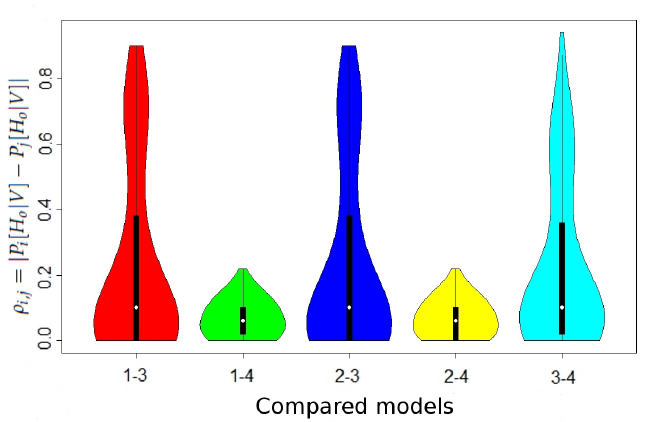
Figure 1. Distribution of ρ i , j at locus D5S818 in the case of maternal mutation. Width shows the